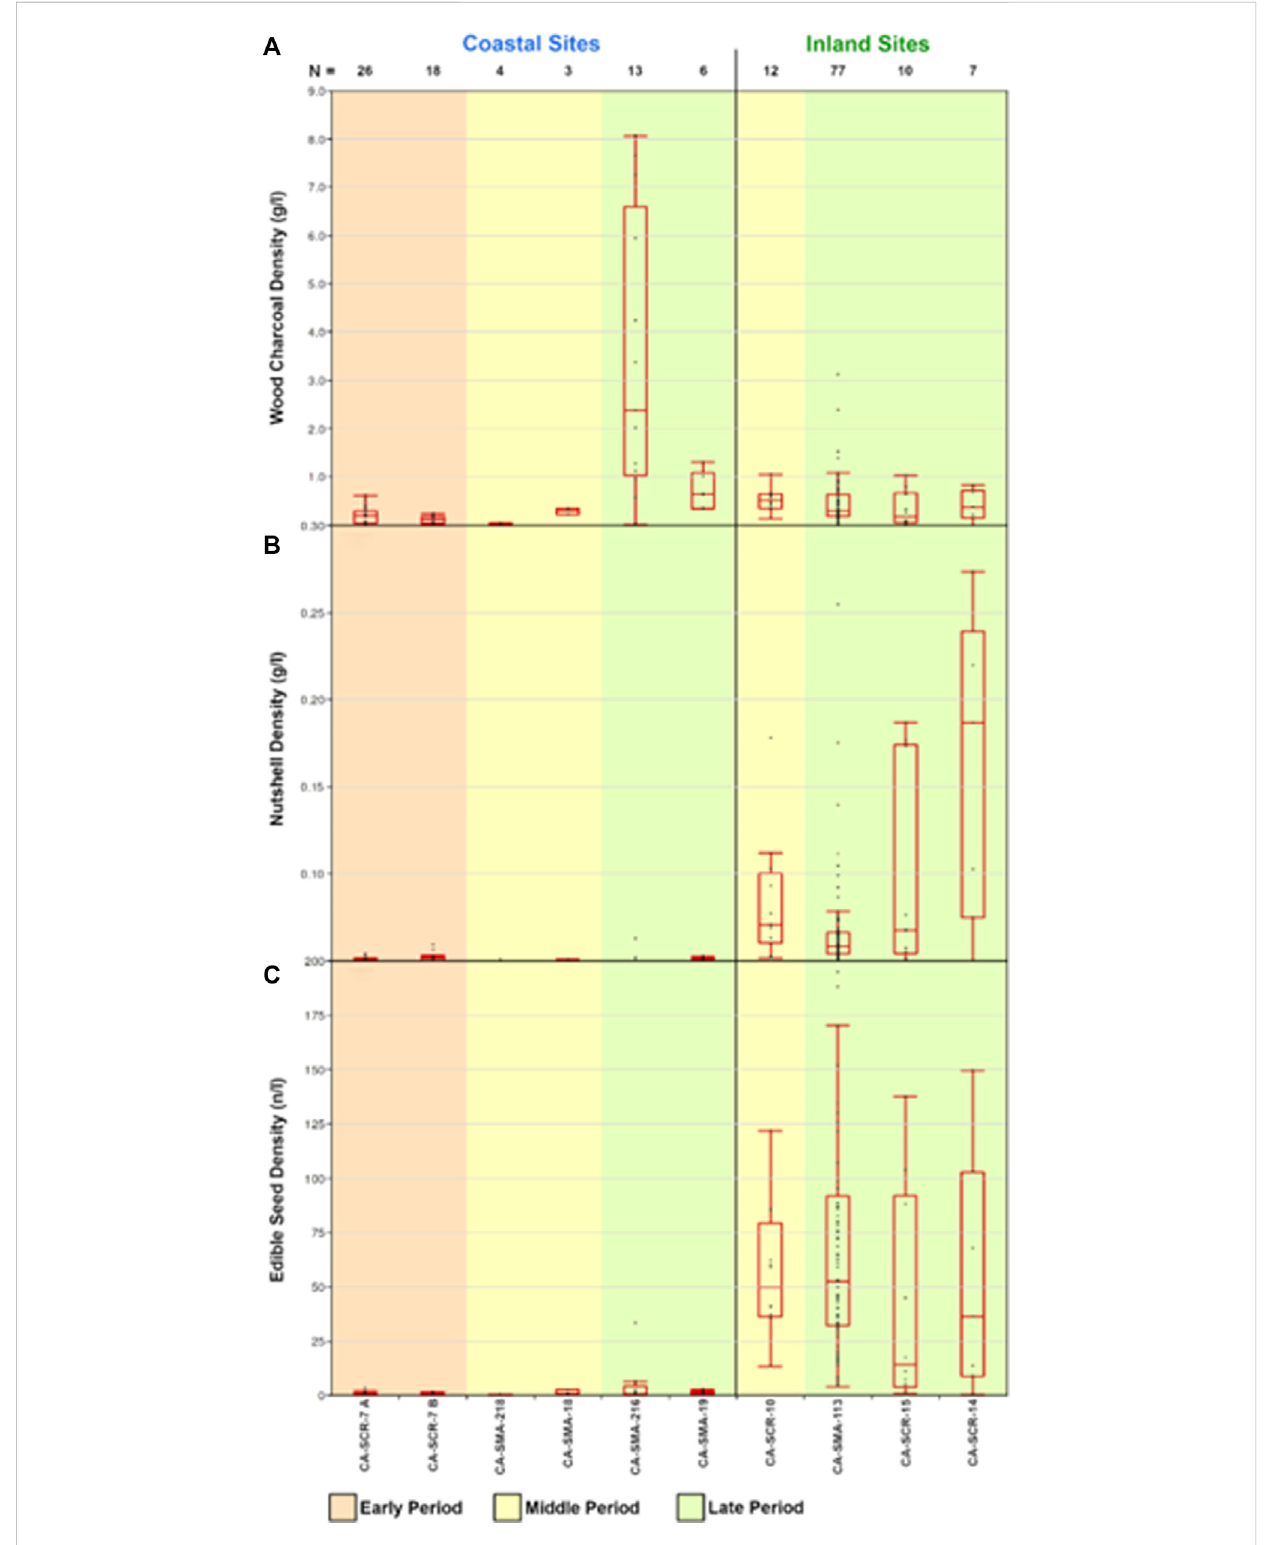
FIGURE 4 Box plot inter-site comparison of: (A) wood charcoal density (g/L); (B) edible nutshell density (g/L); and (C) edible seed density (n/l). Each data point represents a fl otation sample (Cuthrell, in